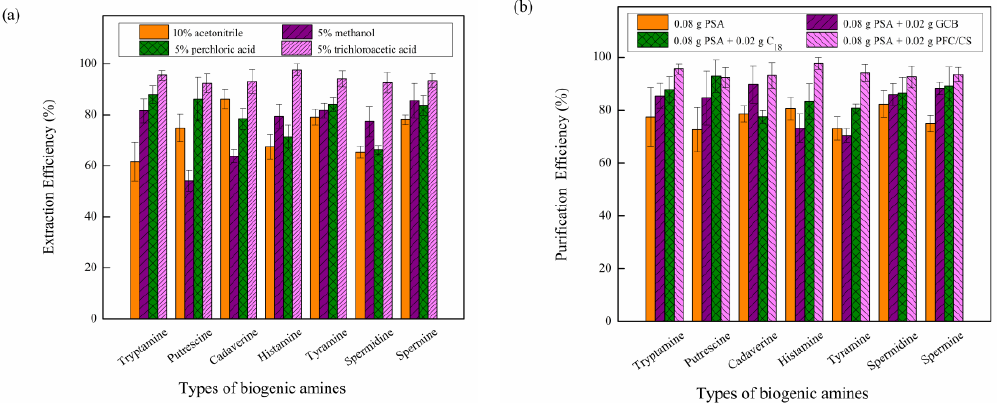
Figure 2. ( a ) Extraction effect of four organic solvents, 10% acetonitrile, 5% methanol, 5% perchloric acid and 5% trichloroacetic acid. ( b ) Purification effect of four adsorbents, 0.08 g PSA, 0.08 g PSA + 0.02 g GCB, 0.08 g PSA+ 0.02 g C 18 , and 0.08 g PSA+ 0.02 g PFC/CS.